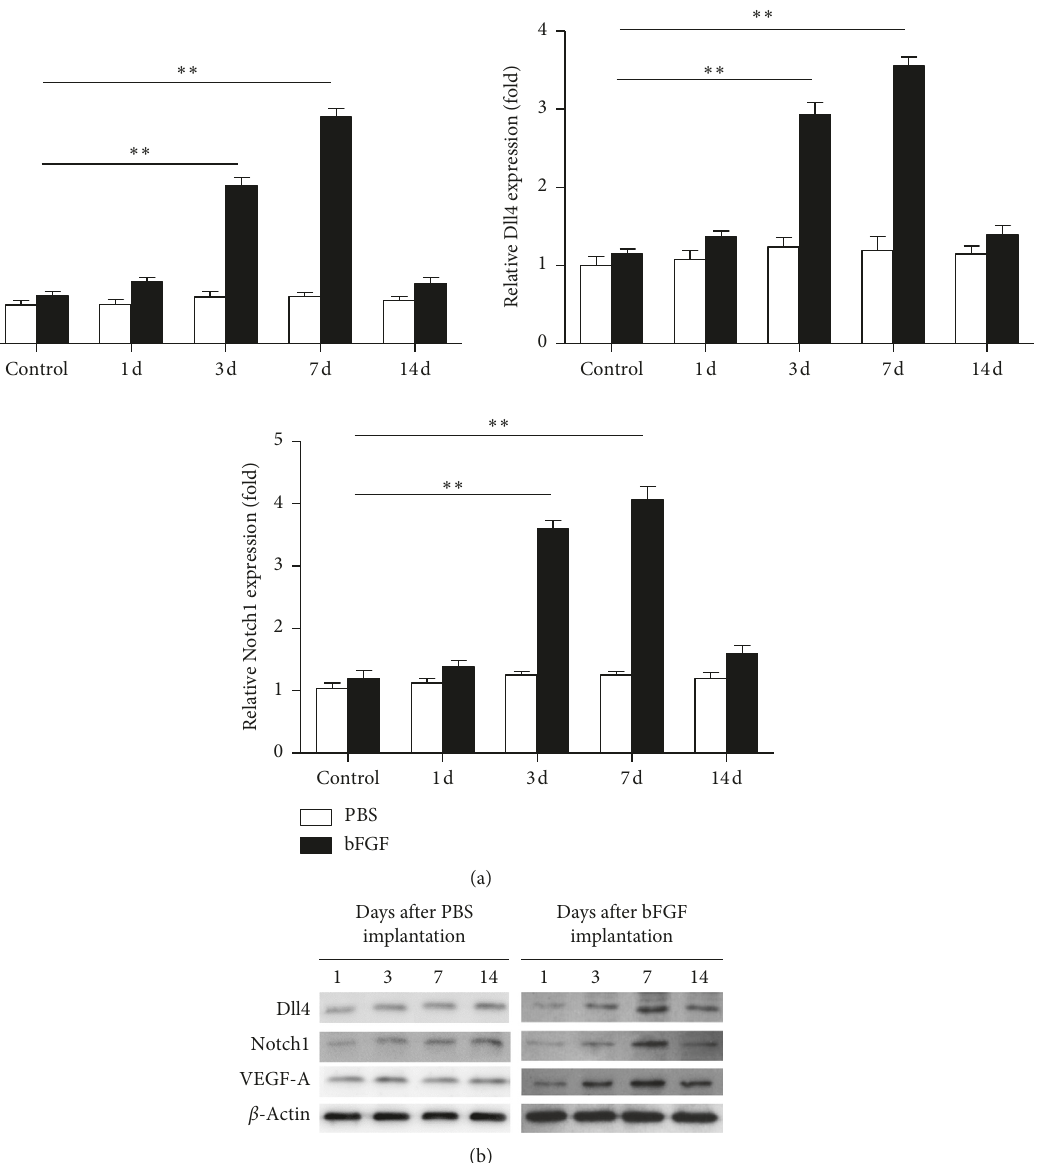
Figure 2: (a) VEGF-A, Notch1, and Dll4 mRNA expression levels on the indicated days in the corneal micropocket assay after PBS stimulation and bFGF stimulation were similar; bFGF-implanted corneas (days 1, 3, 7, and